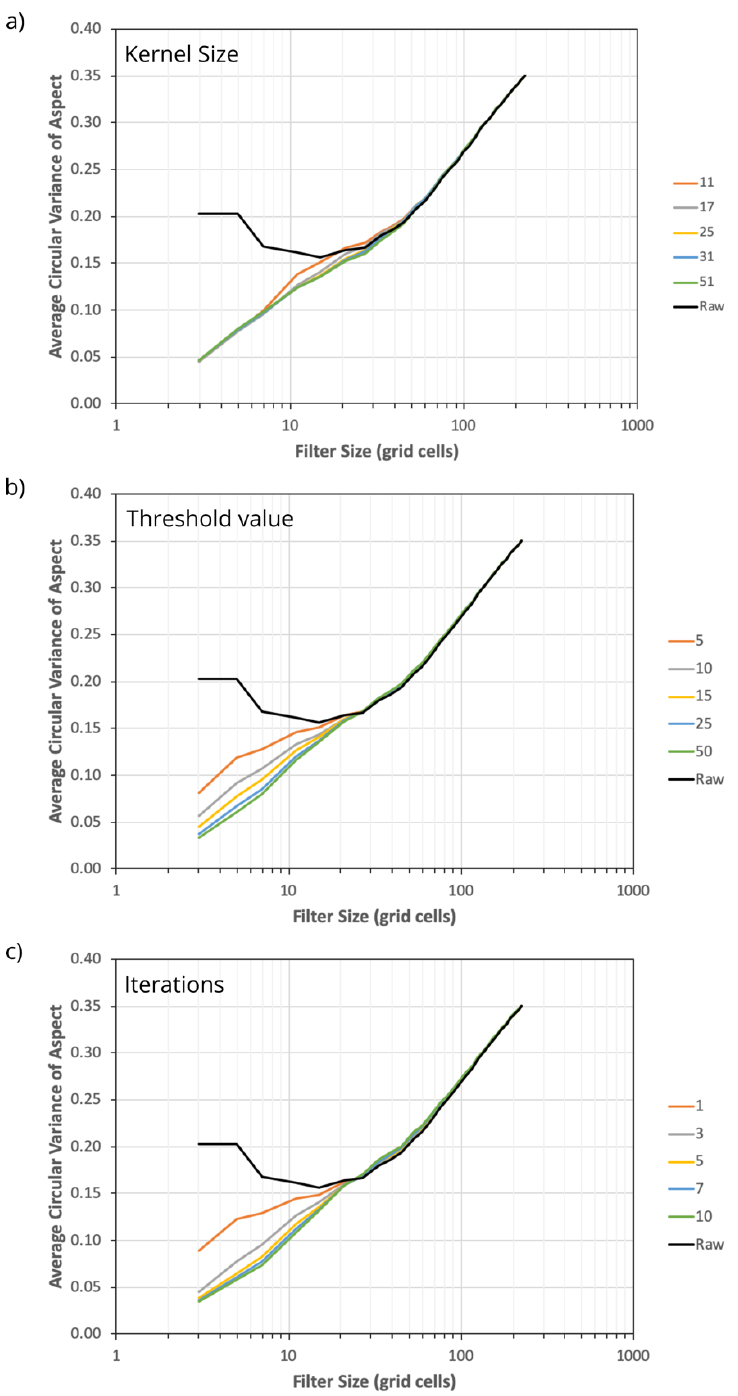
Figure 4. The e ff ects of Feature Preserving DEMs (FPDEMs) smoothing on the CVA scale signature of the study site DEM including varying ( a ) the filter kernel size from 11 × 11 to 51 × 51 (in grid cells; each test used a threshold of 15 ◦ and three iterations), ( b ) the normal vector di ff erence threshold from 5 ◦ to 50 ◦ (each test used 17 × 17 kernels and three iterations), and ( c ) the number of elevation-update iterations from 1 to 10 (each test used 17 × 17 kernels and a threshold of 15 ◦